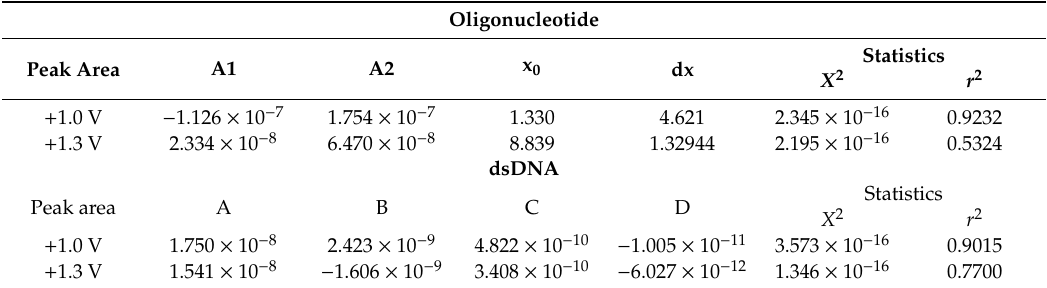
Table 4. Correlation equation parameters and statistics between oligonucleotide / dsDNA individual peak areas and naringin